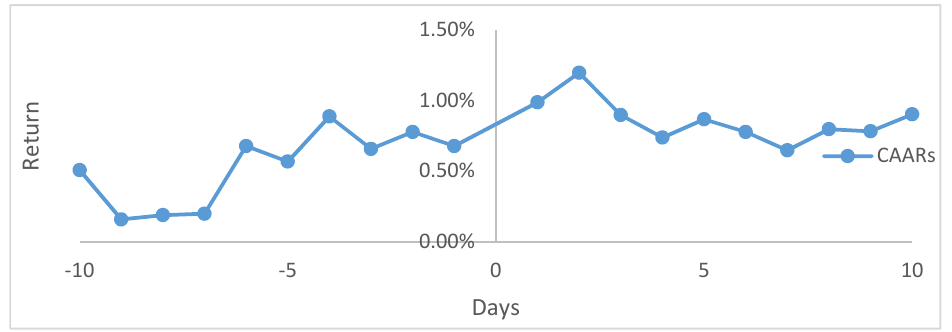
Figure 5. Cross-border acquisitions other than in the US and UK. Source: Authors’ own calculation.